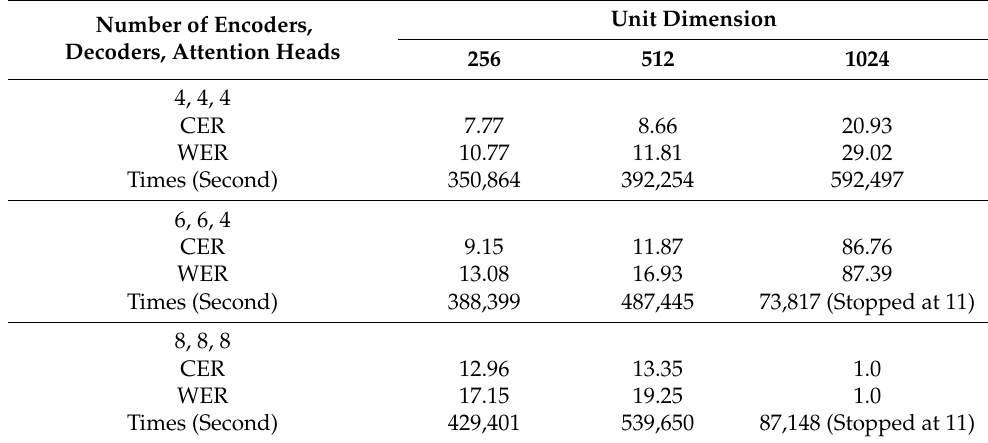
Table 3. Hyperparameter tuning results of the proposed ResNet-101T model.